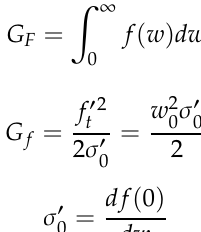
G in the load–displacement curve [30]. G and F f